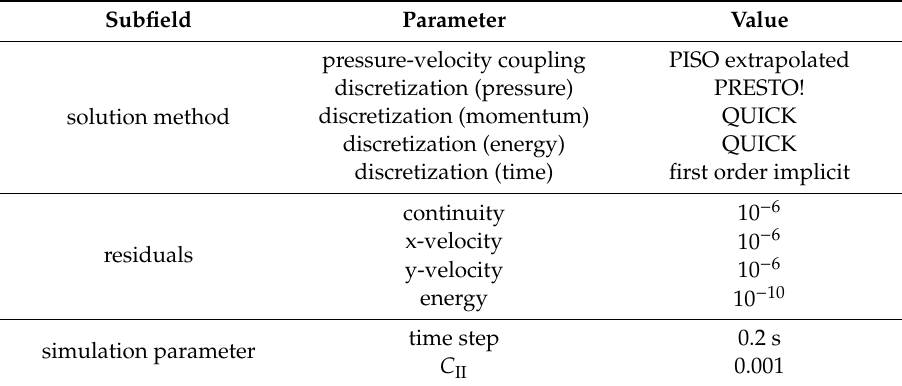
Table A1. Final solver settings.